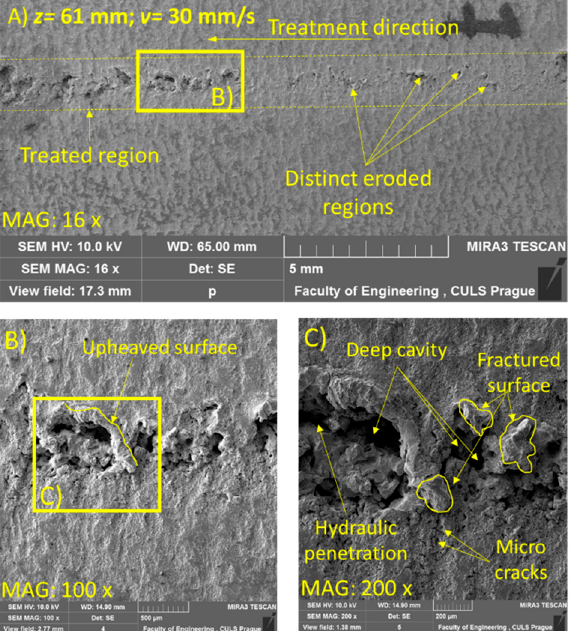
Figure 8. SEM image of sample subjected to p = 70 MPa, z = 61 mm, and v = 30 mm/s ( A ) at magnification 16 × , ( B ) At magnification 100 × and ( C ) At magnification 200 ×